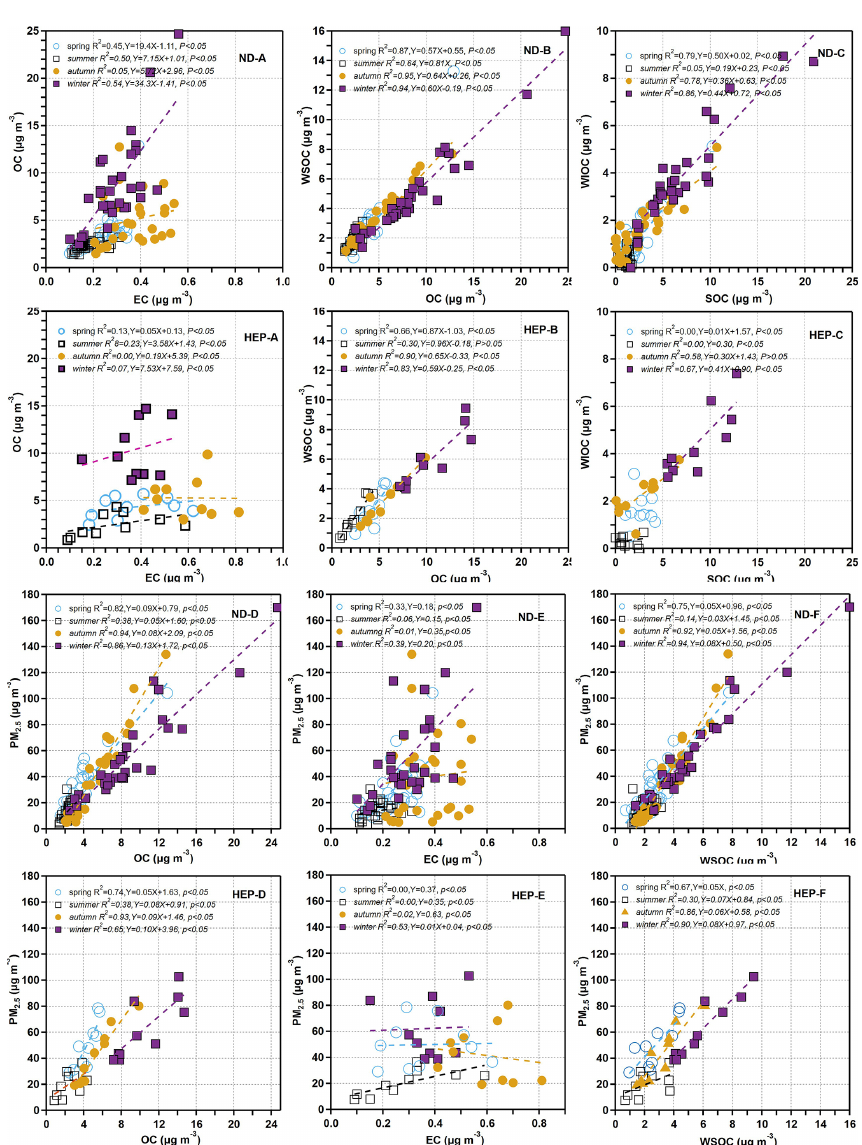
Figure 5. Scatter plots of selected carbonaceous components in PM 2 . 5 in Tianjin at ND and